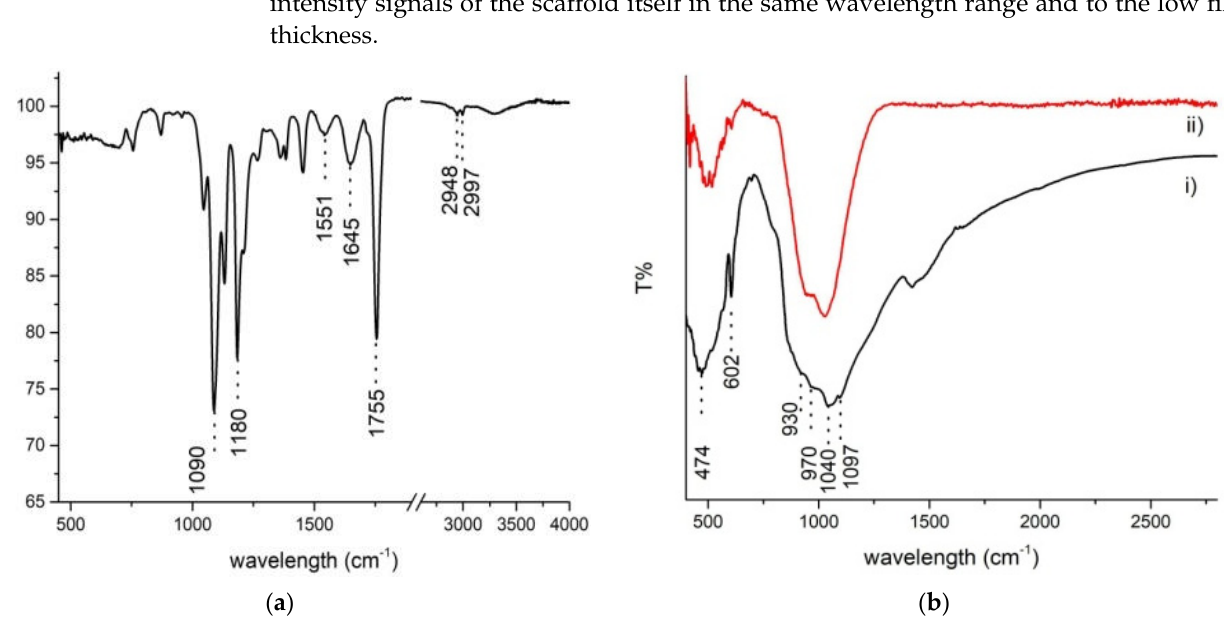
6 of 12 Figure 2. XRD spectra of the Mn ‐ BG target (i) (black line) and of the Mn ‐ BG film deposited on silicon substrate (ii) (red line).